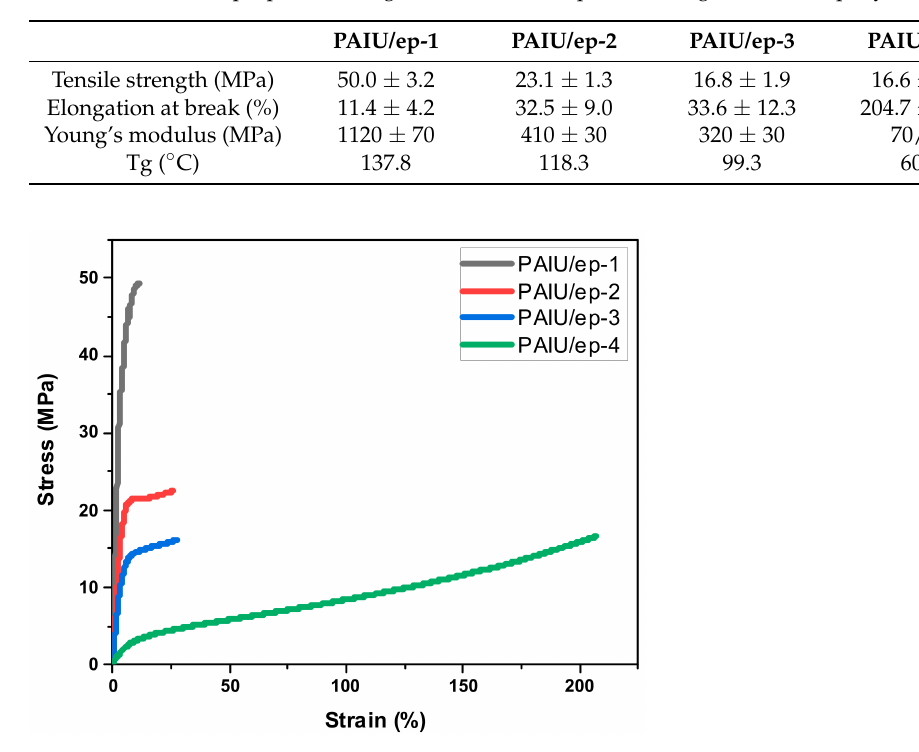
Table 2. Mechanical properties and glass transition temperatures (Tgs) of PAIU/epoxy IPNs.